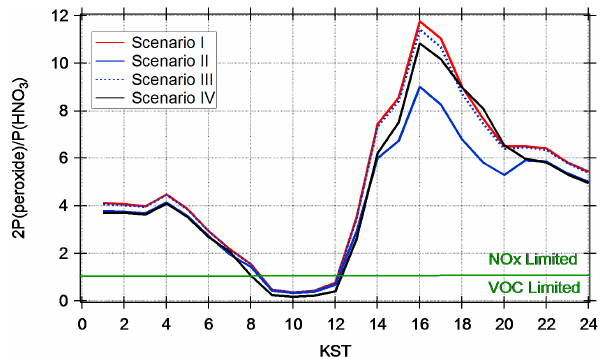
/P HNO calculated 3 2 O 2